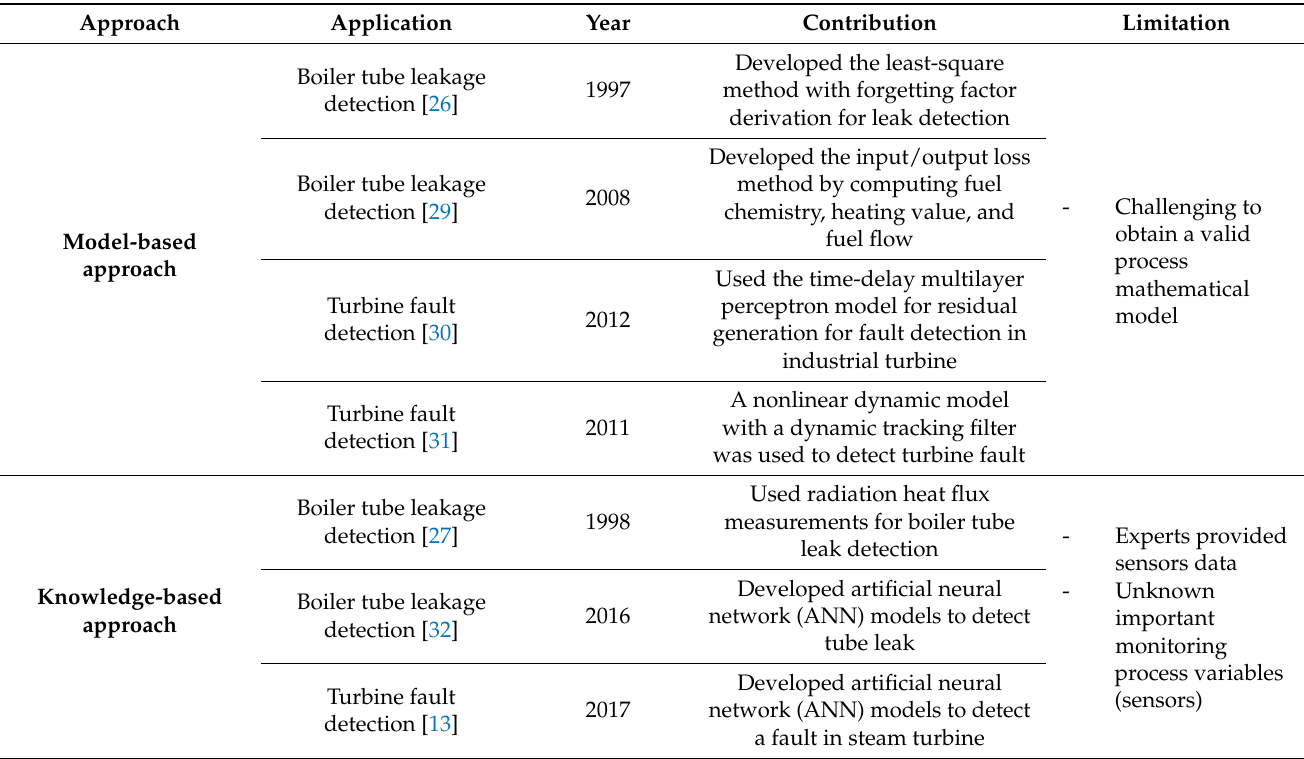
Table 1. State-of-the-art literature survey boiler and turbine fault detection in TPP.